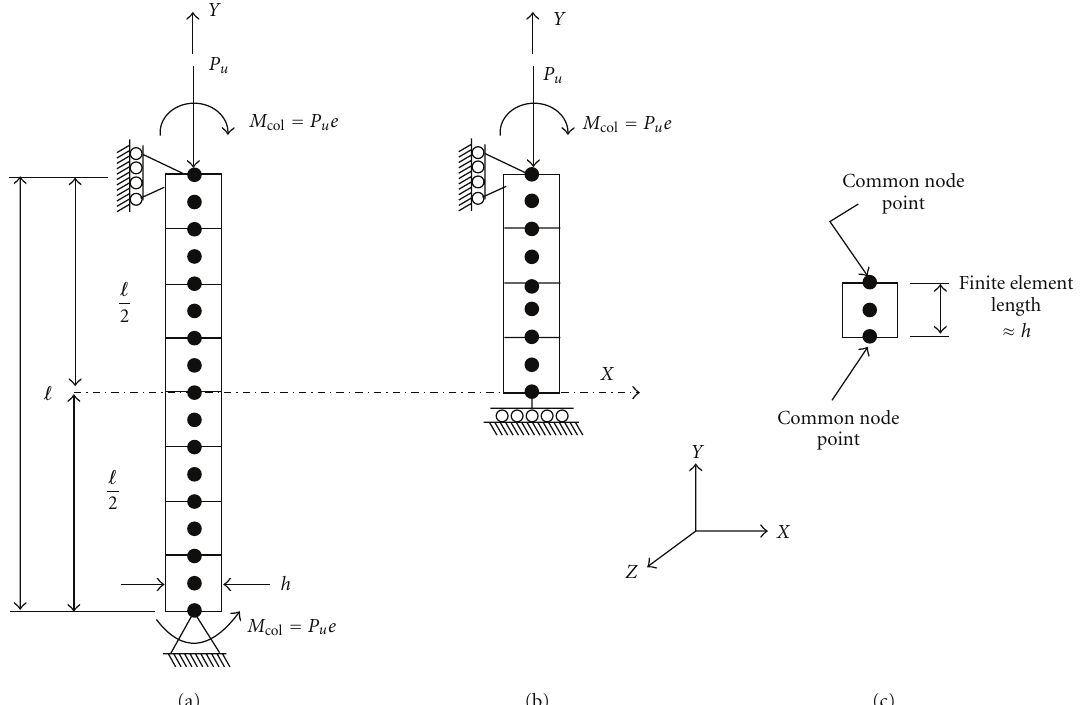
Figure 4: FEM of column (member): (a) column in symmetrical single-curvature bending, (b) one-half length of column used for analysis, and (c) finite element